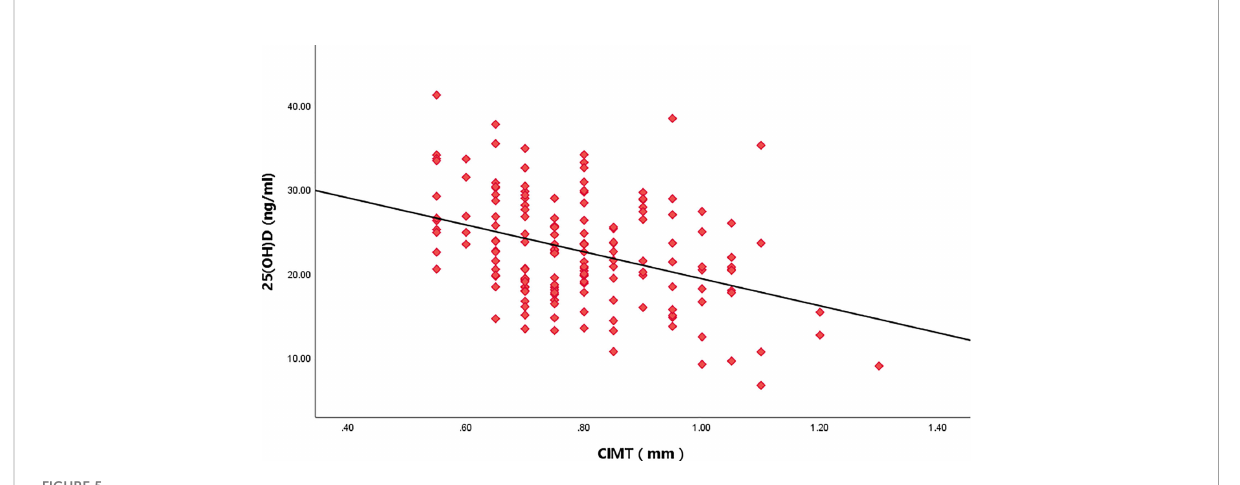
FIGURE 5 Relationship between serum 25(OH)D level and